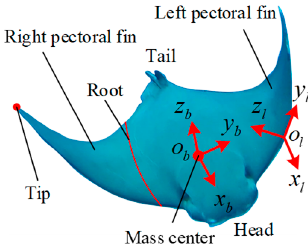
Figure 1. Coordinate frames of the rays.